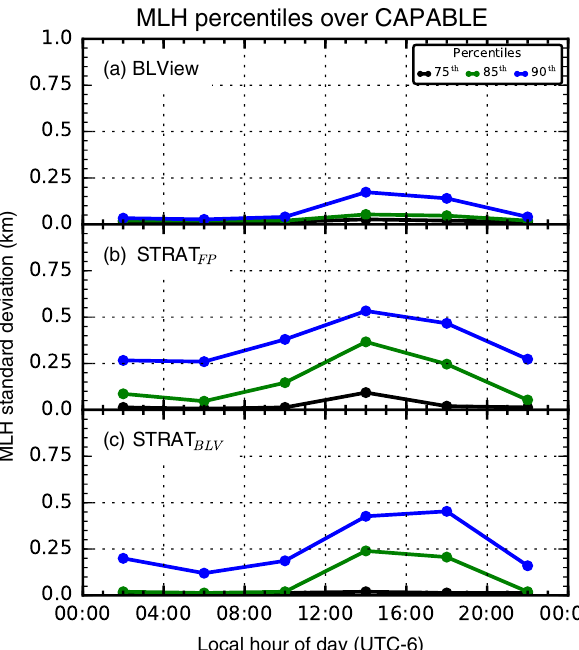
Figure 4. Percentiles for MLH SD throughout the day from the CAPABLE site. Data in panel (a) were collected and processed in BLView, data in panel (b) were collected with the Python script and processed in STRAT, data in panel (c) were collected in BLView and processed in STRAT. It is observed that variability was maximum during the afternoon regardless of collection method or processing